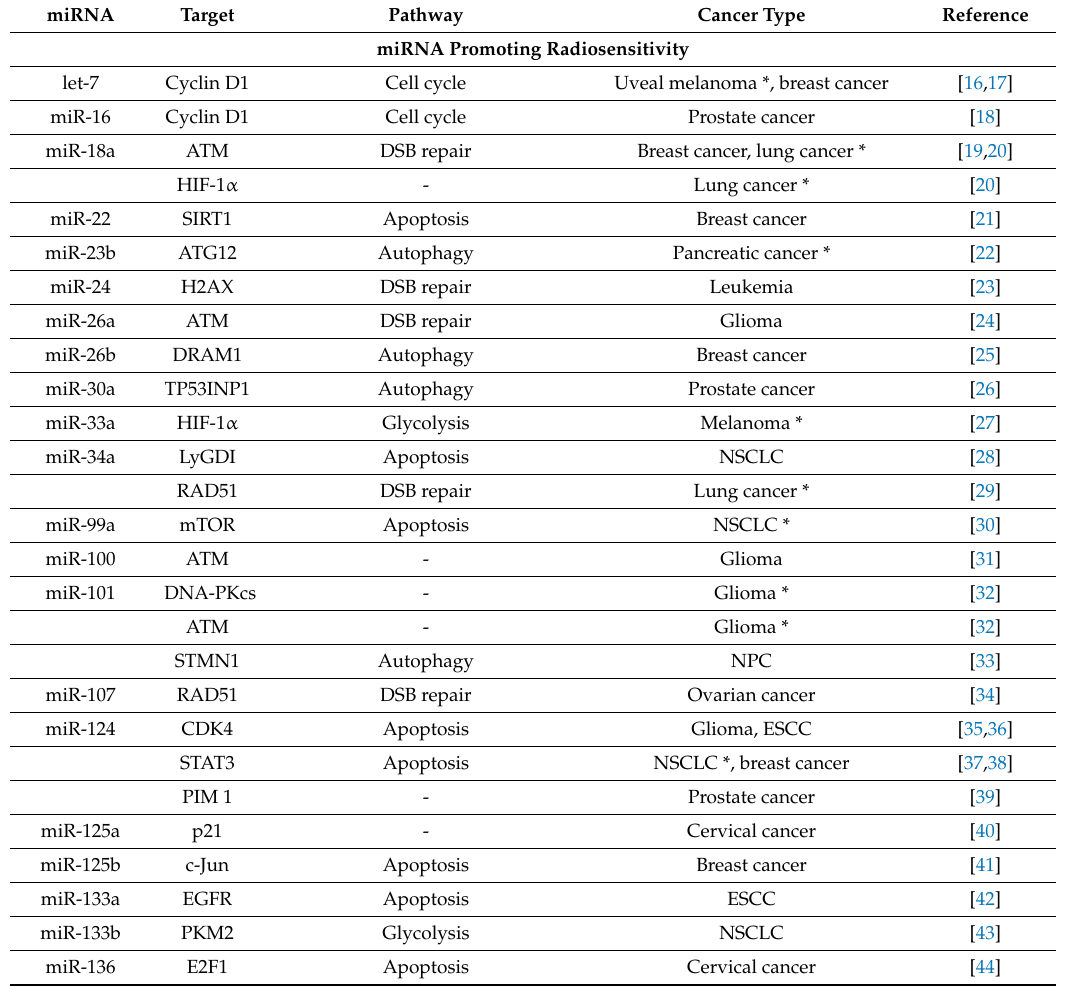
Table 1. microRNAs (miRNAs) promoting radiosensitivity or radioresistance in cancer cells. miRNA Target Pathway Cancer Type Reference miRNA Promoting